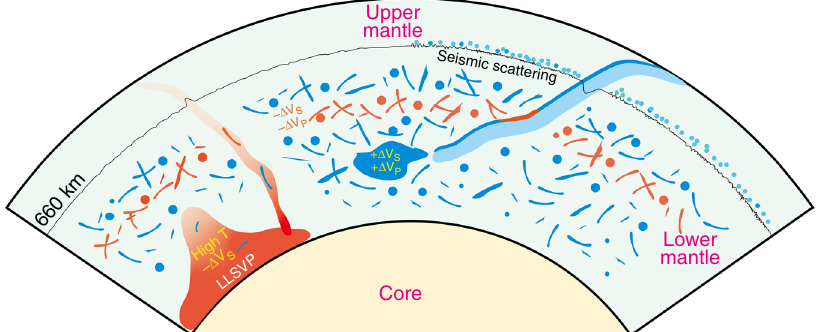
Fig. 5 Schematic diagram for subducted oceanic crust in the lower mantle. The velocity heterogeneities caused by subducted oceanic crust are noticeably depth-dependent: it produces large negative velocity anomalies at the mid mantle but high velocity heterogeneities at the lower part of mantle. The presence of subducted oceanic crust could provide explanations for seismic scatters and high velocity heterogeneities (~2%) in the lower mantle imaged by seismic tomography, but LLSVPs likely do not originate from subducted oceanic crust. The 660-km discontinuity, which de fi nes the top of the lower mantle, was also found to show the small-scale topographic variations 71